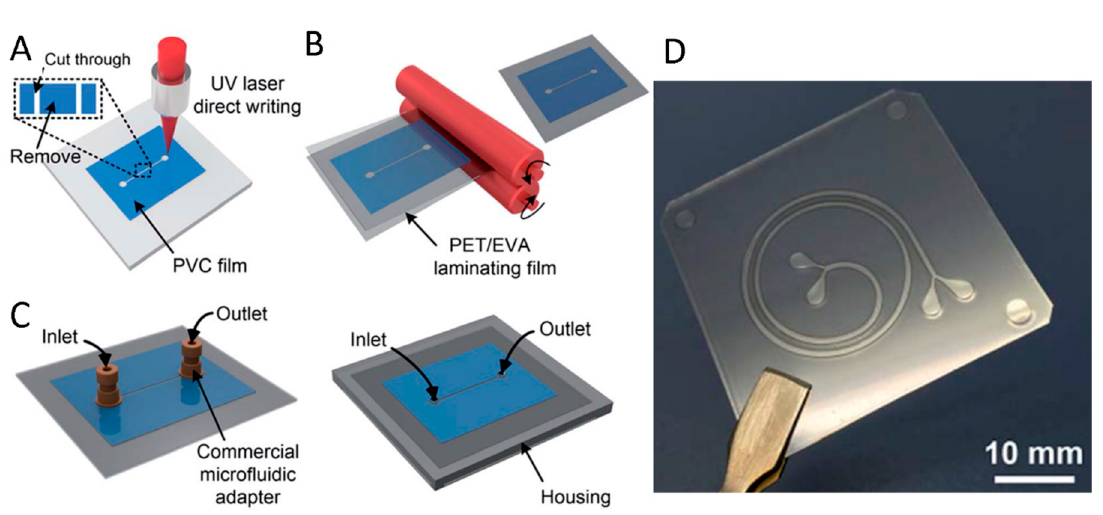
Figure 1. Schematic illustration of the fabrication process of the polymer film chip: the channel is realized by cutting a sheet of PVC film by UV laser direct writing ( A ); chip lamination by using PET/ EVA laminating films ( B ); two kinds of chip-to-world connexions; ( C ) Polymer film chip with a spiral microchannel ( D ). Reproduced with permission from [52].